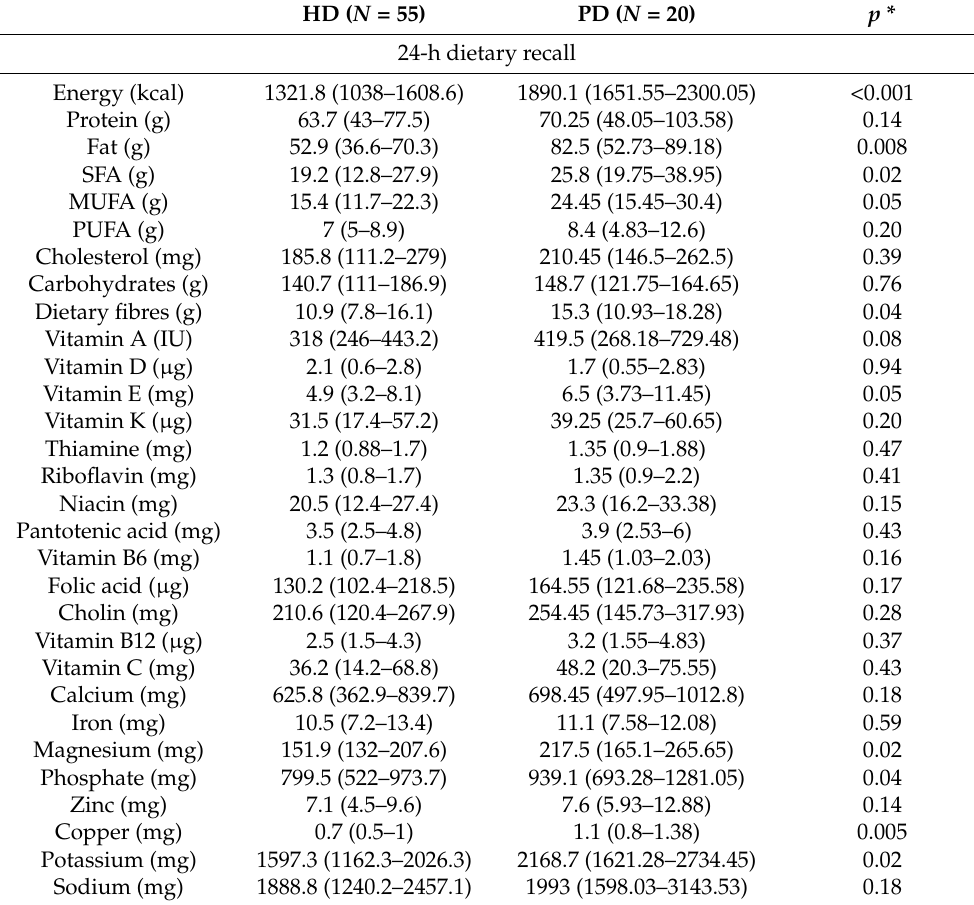
Table 3. Dietary intake and differences regarding dialysis modality.